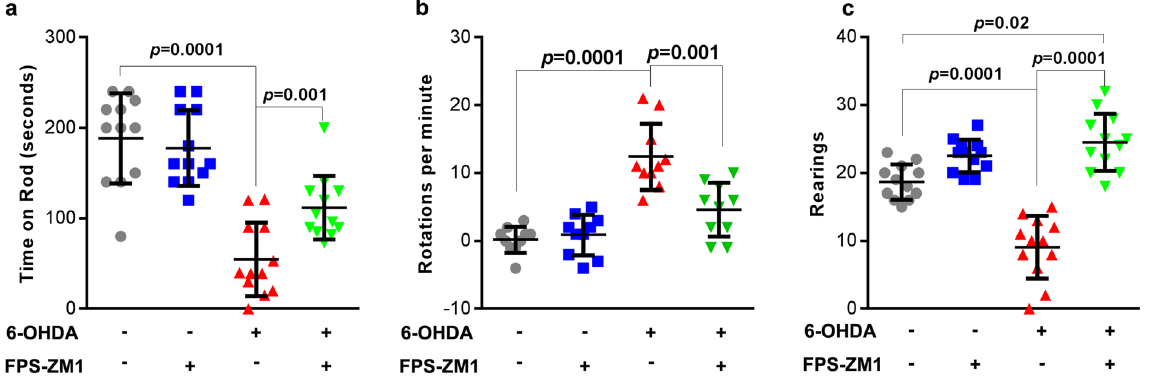
Figure 7. FPS-ZM1 protects rats from 6-OHDA-induced motor deficits. Locomotor abilities of rats injected with 6-OHDA were examined 14 days after the injection. ( a ) Rotarod test – total time on the rod limited to 4 min. ( b ) Rotational activity after apomorphine challenging. ( c ) Open field rearing test - duration limited to 5 min. Values represent mean ± SD from ten rats per group. One-way analysis of variance and Bonferroni Multiple Comparison post-hoc test were applied to all data. p values are embedded in the figure. n = 12 per group was used for rotarod and rearing test, n = 10 per group was used to measure the rotational